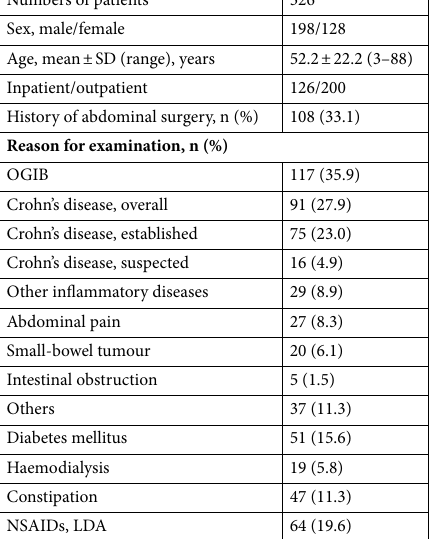
Table 1. Patients’ characteristics. LDA low-dose aspirin, NSAIDs nonsteroidal anti-inflammatory drugs, OGIB obscure gastrointestinal bleeding, SD standard